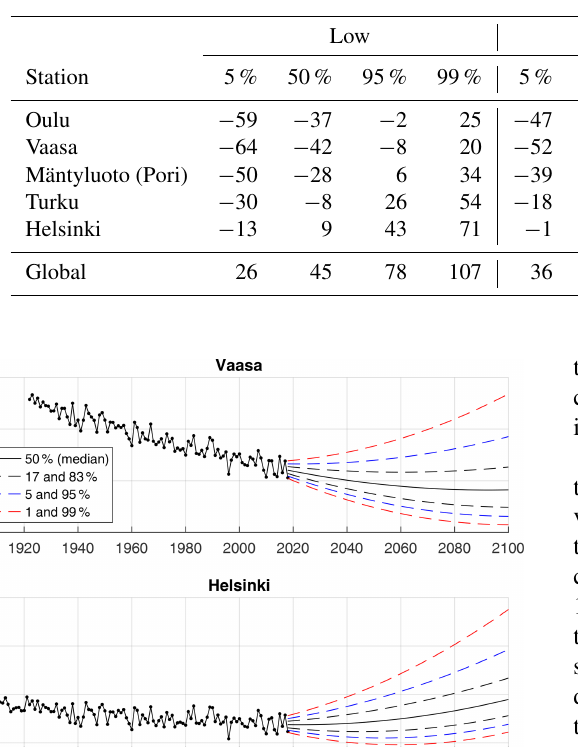
Table 4. Projections of mean sea level change (centimetres) from 1995–2014 to 2100 for some of the largest coastal cities in Finland: Oulu, Vaasa, Pori, Turku, and Helsinki. The global sea level rise over the same period, calculated as a weighted combination of 10 SLR projections, is shown for comparison. The 5th, 50th, 95th, and 99th percentiles are given for three emission scenarios: low (RCP2.6/SSP1-2.6), medium (RCP4.5/SSP2-4.5), and high (RCP8.5/SSP5-8.5).